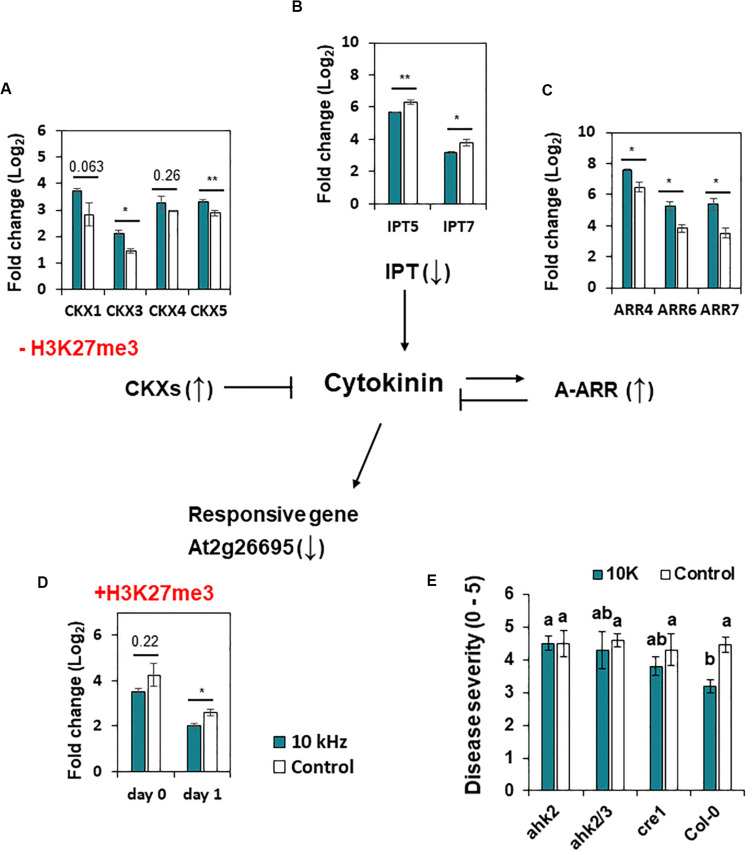
Expression of cytokinin (CK) signaling genes and H3K27me3 modification in A. thaliana. (A–D) Expression of CK dehydrogenase/oxidase (CKX) genes at day 1 (A), adenosine phosphate isopentenyl-transferase (IPT) genes at day 0 (B), type-A Arabidopsis thaliana response regulator (ARR) genes at day 0 (C), and CK-responsive genes (At2g26695) (D) in 10 kHz-treated and control plants. CXK1 and At2g26695 showed reduced and enhanced H3K27me3 modification in 10 kHz-treated and control plants, respectively. Data represent mean ± SE (n = 3–4). Asterisks indicate significant differences (*p < 0.05; **p < 0.01; Student’s t-test). (E) Disease severity in 10 kHz-treated and control CK receptor mutant plants at 14 dpi with R. solanacearum. Data represent mean ± SE. Different letters indicate significant differences (n = 10; p < 0.05; Fisher’s LSD test).